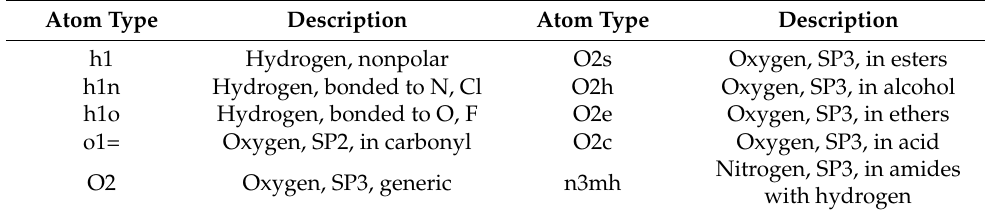
Table 2. Atomic types and their definitions in force